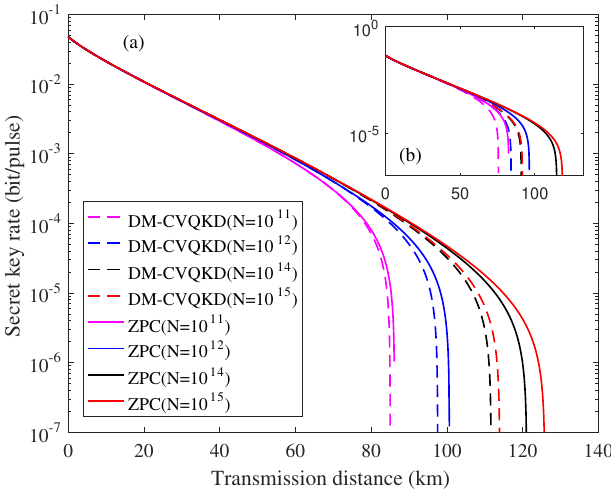
Figure 8. Finite-size key rate of CVQKD involving the ZPC operation for ε = 0.01, where the ( a ) represents eight-state DM source preparation, and inset ( b ) represents four-state DM source